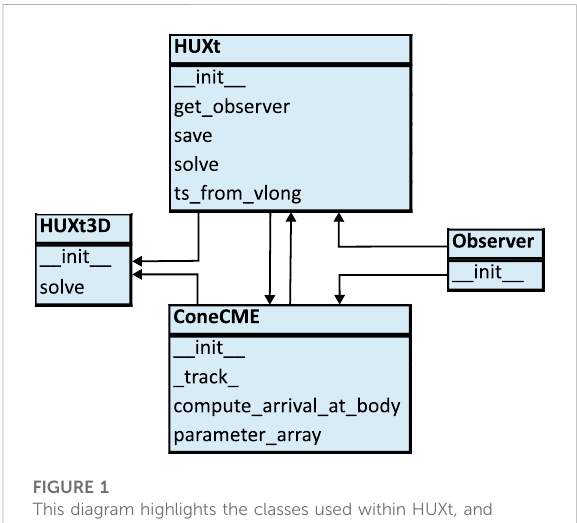
This diagram highlights the classes used within HUXt, and their associated methods, and the relationships between